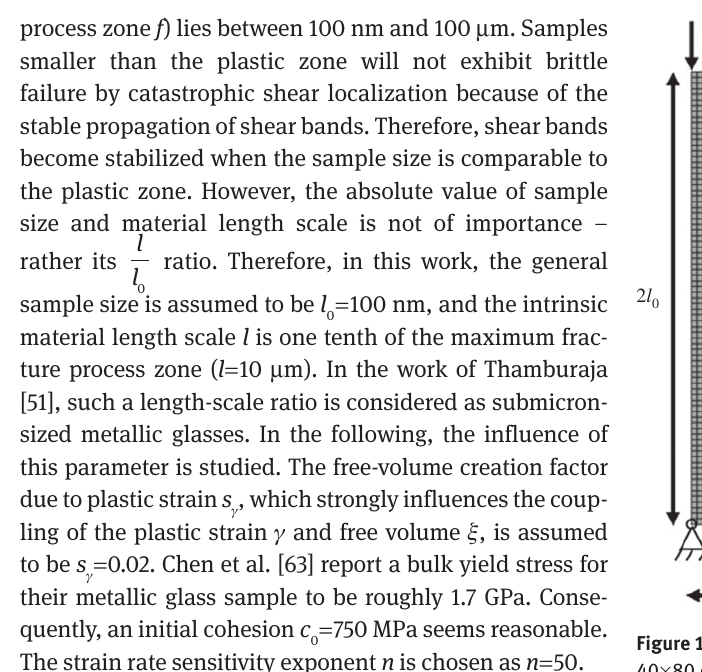
Figure 1 Sample S 40 × 80 elements. A defect is placed near the center to trigger the shear band in the